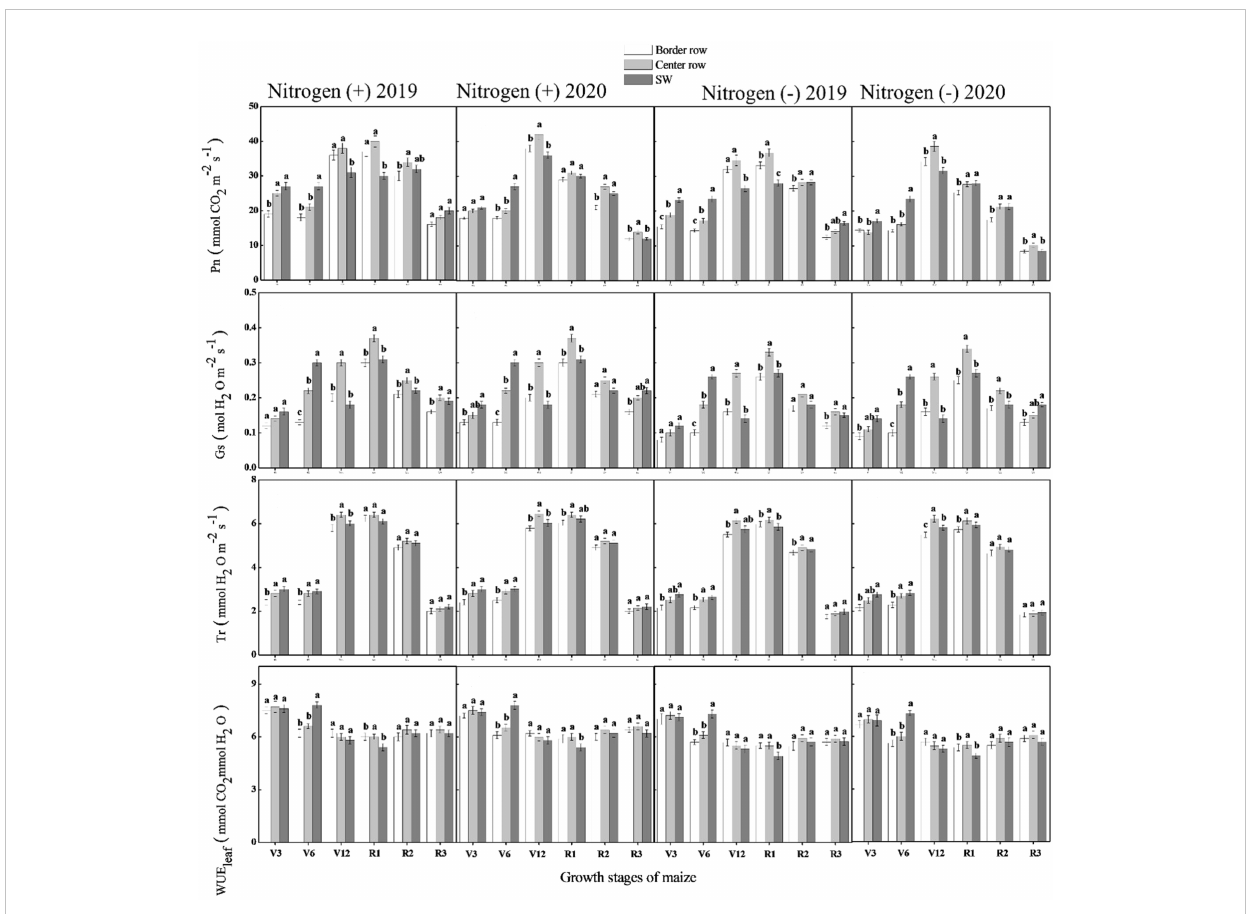
FIGURE 7 Photosynthesis rate (Pn), stomatal conductance (Gs), transpiration rate (Tr) and leaf water use ef fi ciency (WUEleaf) in the border-, center- and sole maize (SM) crop at various growth stages under with- and without N application. Different letters on the top of each bar indicate signi fi cant differences among the various crop growth stages, as calculated by Tukey ’ s HSD test at P ≤